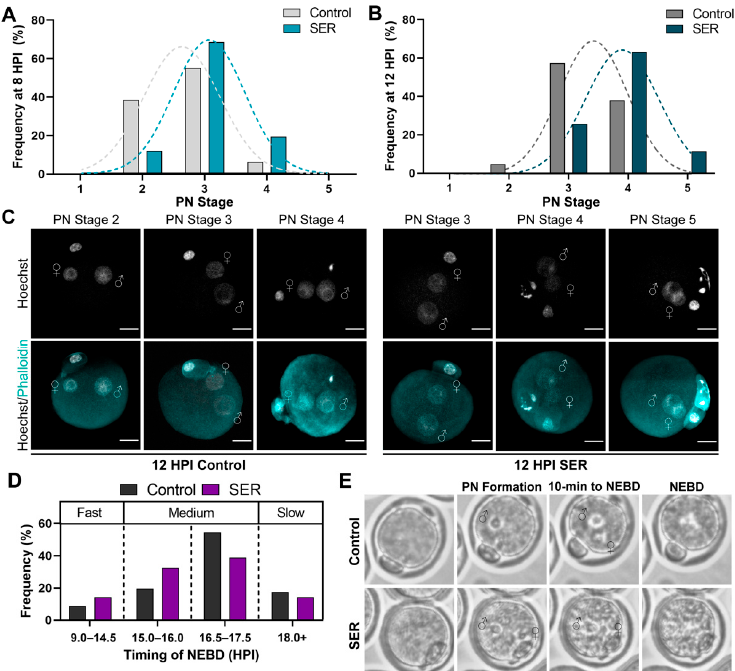
Figure 2. Effects of SER on pronuclear staging and pronuclear envelope breakdown (NEBD). ( A ) Frequency of 8 HPI control- and SER-generated PN stage (1–5) from 3D-confocal analyses. N = 9 independent experiments; number of embryos: control = 145, SER = 133. Chi-square: p < 0.0001. ( B ) Frequency of 12 HPI control- and SER-generated PN stage (1–5) from 3D-confocal analyses. N = 10 independent experiments; number of embryos: control = 129, SER = 133. Chi ‐ square: p < 0.0001. ( C ) Representative confocal microscopy images of 12 HPI control ‐ and SER ‐ generated embryos. Cortical actin cytoskeleton (Phalloidin) and DNA (Hoechst) are shown in cyan and grey, respectively. Male PN: ; female PN: ; and scale bar: 20 µ m. ( D ) Quantification of NEBD timing comparison from ♀ ♂ time-lapse analyses. Analysis categories: fast (9.0–14.5 HPI), medium I (15.0–16.0 HPI), medium II (16.5–17.5 HPI) and slow (18.0+ HPI). N = 4 independent experiments, 10–15 embryos per experiment per condition. ( E ) Representative control- and SER-generated time-lapse images of events leading to NEBD. Male PN: , and female PN: ♀ ♂